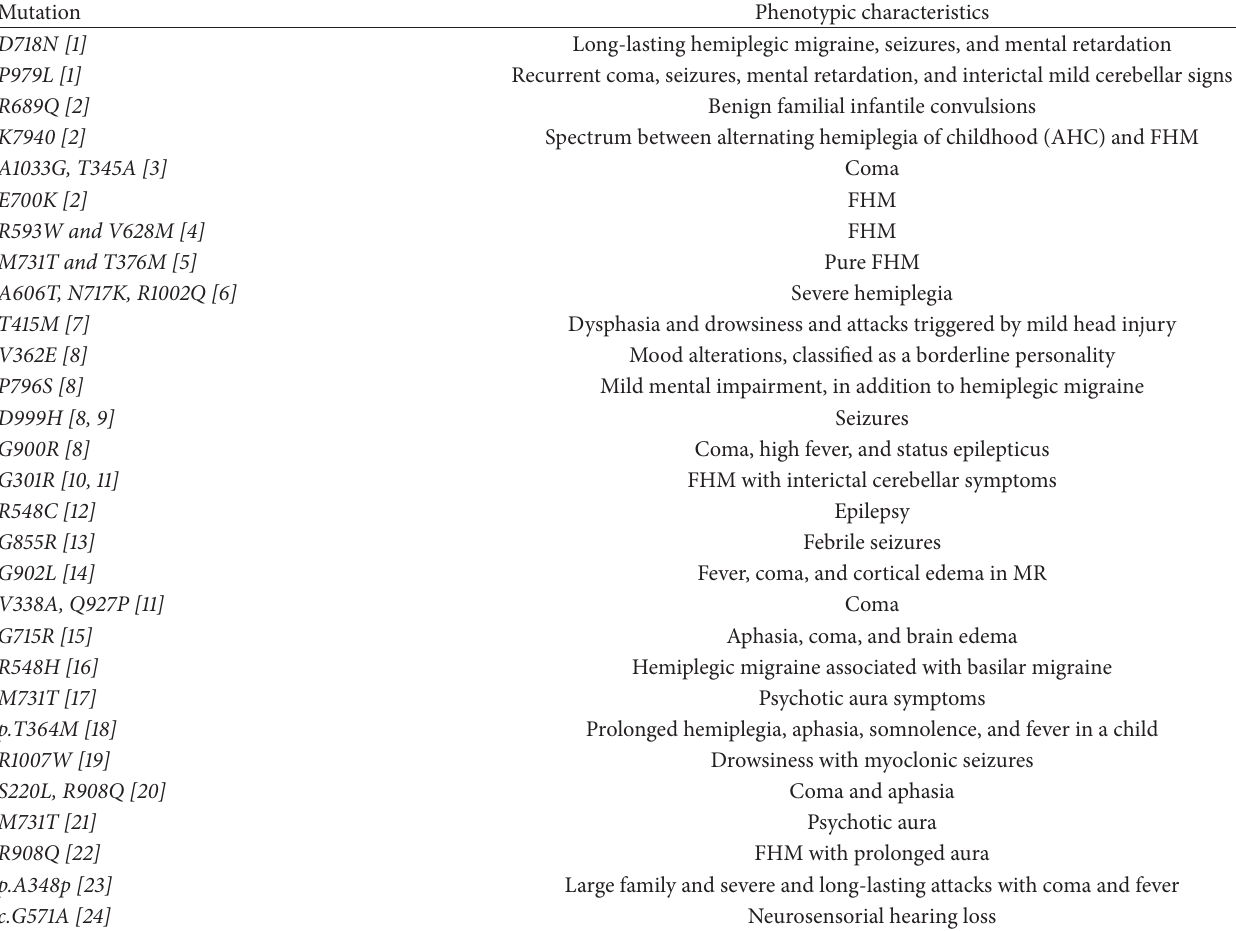
Table 1: Mutations described in ATP1A2 gene related to